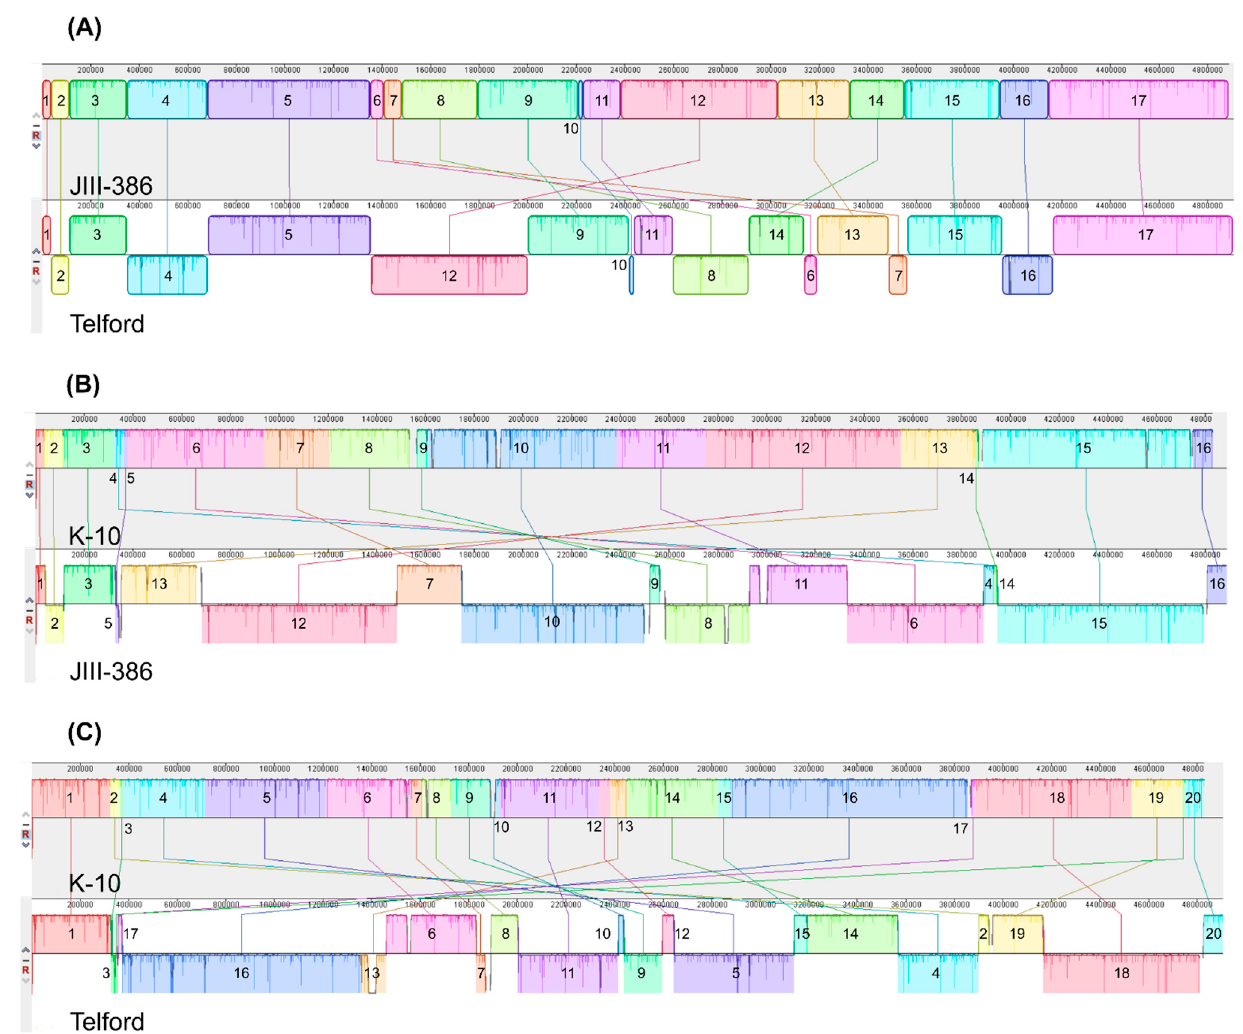
Figure 4. Pairwise comparison of MAP JIII-386, Telford and K-10 genome sequences using Mauve 2.4 [53]. The scales are in base pairs. The dna A gene is positioned at 0 kb. Homologous segments with similar DNA profile among the strains are represented by identically colored boxes. A number was assigned to each segment. Lines connect identically colored boxes. Segments below the centerline indicate inverse orientation. ( A ) MAP JIII-386 and Telford (MAP-S/type III and I): Eight of the 17 total segments are revers complementary orientated including rearrangements of four segments (~35% of the total genome size). In addition, two segments with the same orientation were rearranged. ( B ) MAP K-10 and JIII-386: Seven out of 16 total segments are revers complementary orientated including three rearrangements (~68% of the total genome size). Three segments that were not in the reverse order were found at different relative chromosomal locations. ( C ) MAP K-10 and Telford: Nine of 20 total segments are reverse complementary orientated including three rearrangements (~65% of total genome size). In addition, six segments, which were not in the reverse complimentary order, were found in different chromosomal positions.